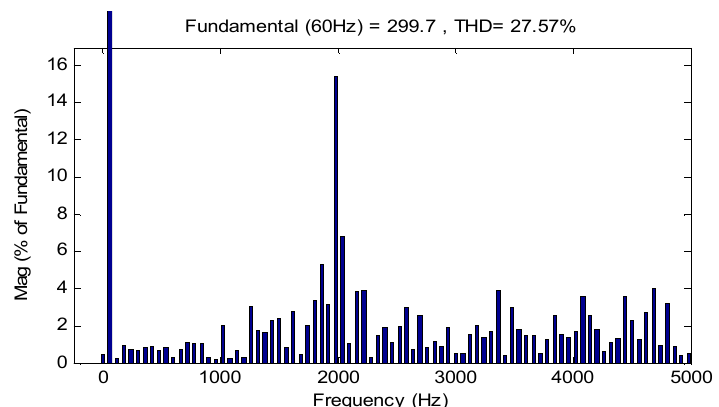
Figure 6. Load voltage waveform.